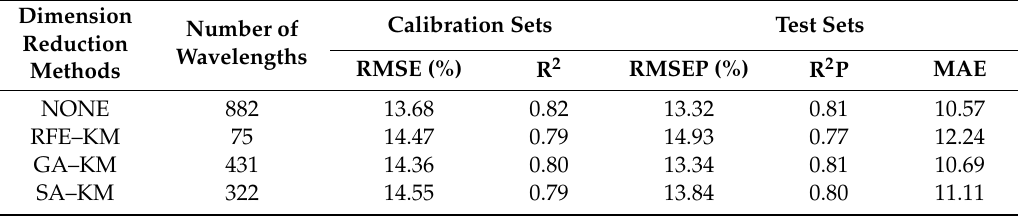
Table 3. Three feature wavelength selection methods based on the PLSR modeling results.